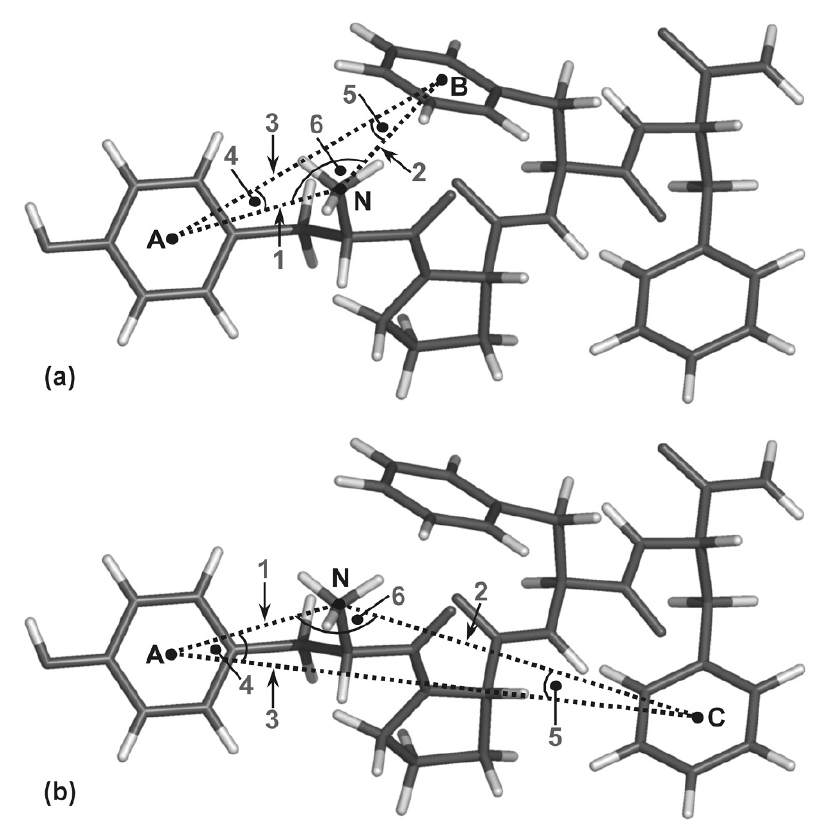
Figure 1. Distances and angles measured between the pharmacophoric points with regard to two subgroups of the pharmacophore elements. ( a ) For the first subgroup: ( 1 ) the ( N-A ), ( 2 ) the ( N-B ) and ( 3 ) the ( A-B ) distances; ( 4 ) the ( N-A-B ), ( 5 ) the ( N-B-A ) and ( 6 ) the ( A-N-B ) angles. ( b ) For the second subgroup: ( 1 ) the ( N-A ), ( 2 ) the ( N-C ) and ( 3 ) the ( A-C ) distances; ( 4 ) the ( N-A-C ), ( 5 ) the ( N-C-A ) and ( 6 ) the ( A-N-C )